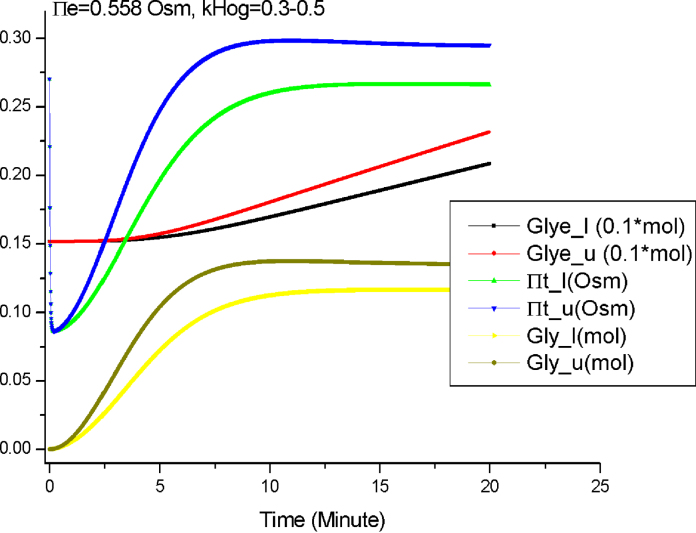
The semi-quantitative simulation by Morven when Πe = 0.558 Osm and kHOG = 0.3–0.5.